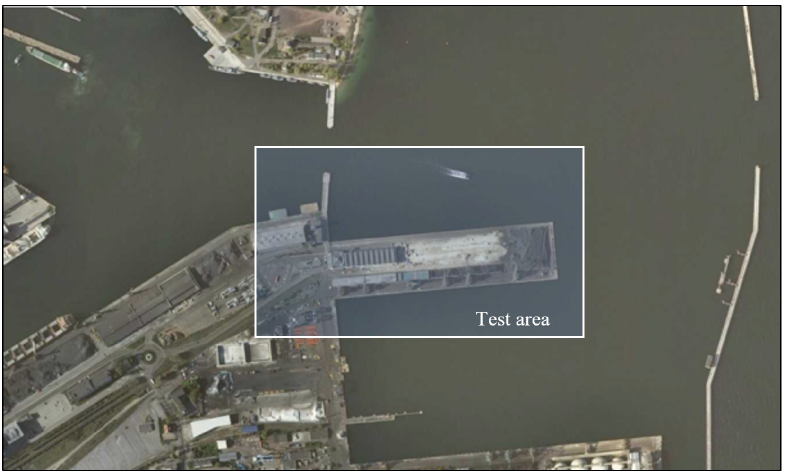
Figure 7. A fragment of an orthophotomap of the port of Gdynia with marked test area (source: goportal.gov.pl (accessed on 9 August